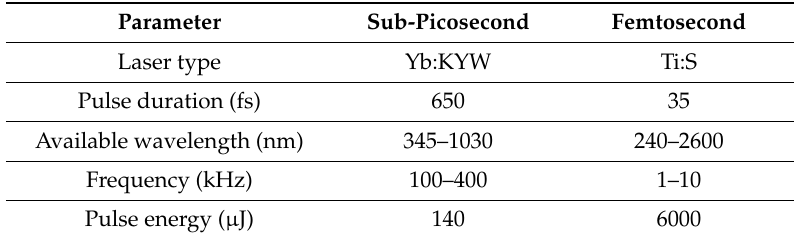
Table 2. The specifications of the two ultrafast lasers used in the experimental setup.